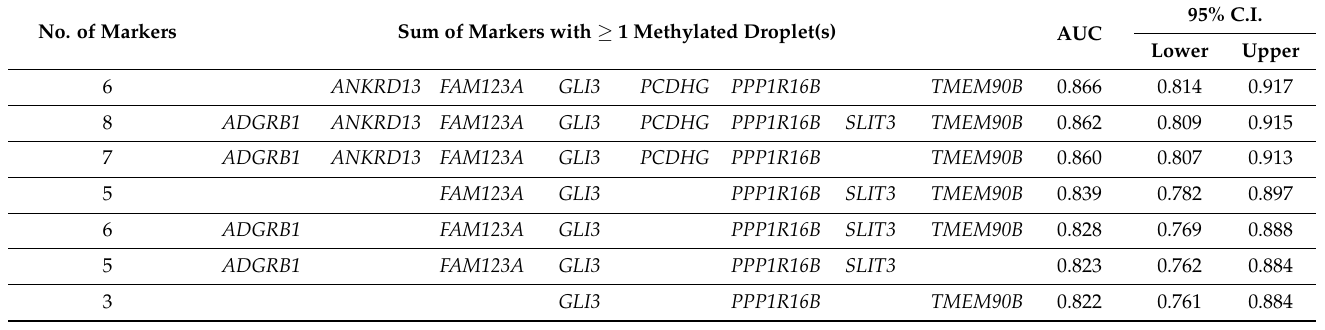
Table 2. Summary of combinatory panels of methylation markers with high area under curves (AUCs). No. of Markers Sum of Markers with ≥ 1 Methylated